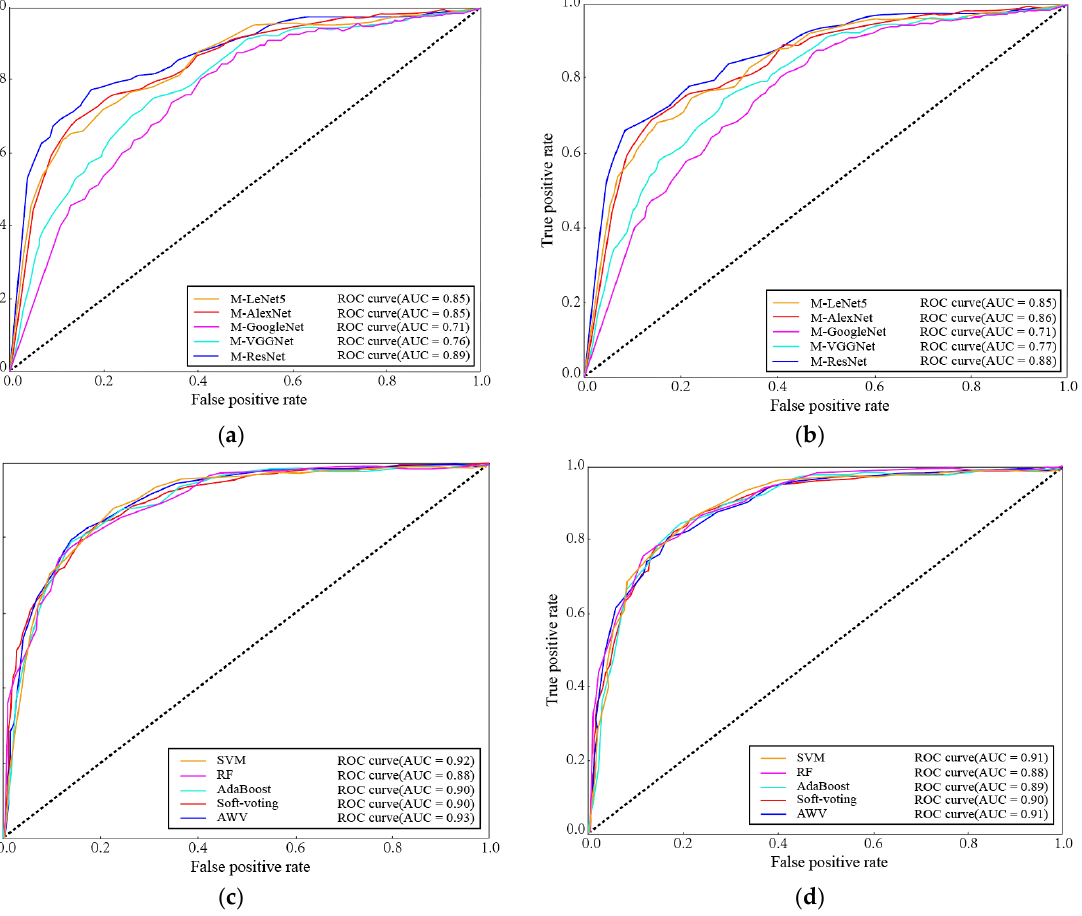
Figure 5. The ROC curves and AUC values: ( a ) M-CNN models on ASL Alphabet, ( b ) M-CNN models on ASLA, ( c ) classifiers on ASL Alphabet, and ( d ) classifiers on ASLA. To obtain the best model in the feature extraction step, three types of multiple deep CNNs were designed: CNN-3, CNN-4, and CNN-5. CNN-3 uses M-LeNet, M-AlexNet, and M-GoogleNet; CNN-4 adds M-VGGNet to CNN-3; and CNN-5 adds M-ResNet to